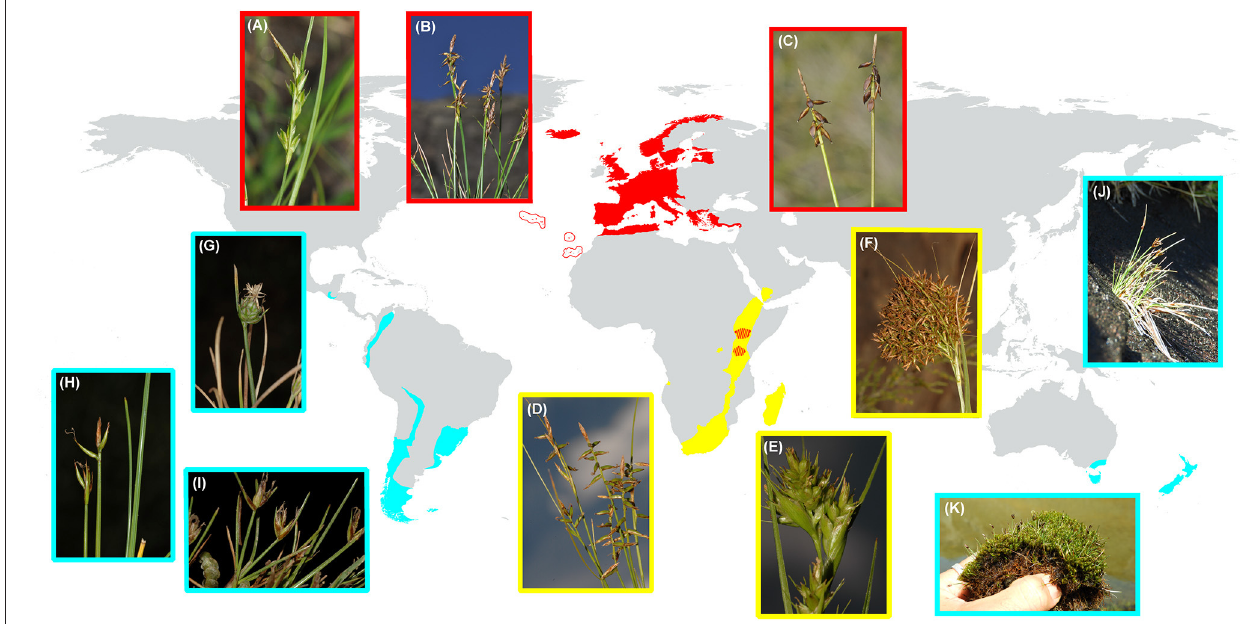
FIGURE 1 | Distribution map of Carex subg. Psyllophorae including its three sections: (1) Psyllophorae in Western Palearctic; (2) Schoenoxiphium in the Afrotropical region; and (3) Junciformes in SA and SW Pacific. The colors of each section are according to Figure 2A (AAR analysis). Photographs display the morphological variation in each section: ( A–C sect. Psyllophorae ) (A) C. distachya Desf., Spain, Ávila, Arenas de S. Pedro, (B) C. macrostyla Lapeyr., Spain, Lerida, Aran Valley, (C) C. pulicaris L., W Iceland; ( D–F sect. Schoenoxiphium ), (D) C. killickii Nelmes, Lesotho, Roma-Semonkong, (E) C. dregeana Kunth, South Africa,